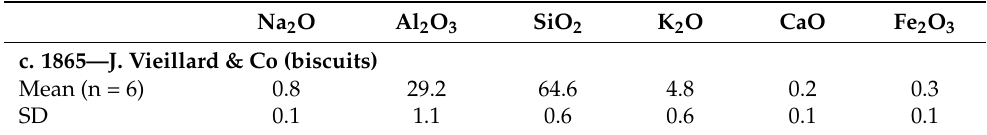
Table 2. Average chemical composition and standard deviation of the biscuit’s body, measured by EDS analysis (wt% normalized to 100%). The data are the average over at least two analyses made in different areas of the ceramic bodies; SD = standard